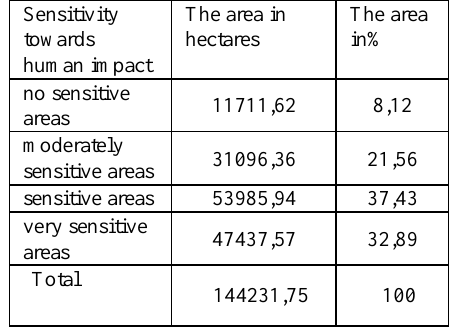
Table 4. Area and percentage of the sensitivity classes to human